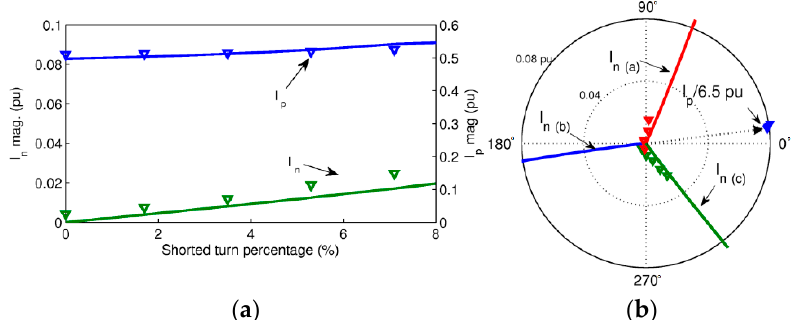
Figure 14. The experimental (symbols) and simulated (solid lines) results at varying shorted turn fault levels of 1.7%, 3.1%, 5.3% and 7.1%: the magnitudes of the positive and the negative sequence currents ( a ) and the negative sequence phasor trajectory for faults in two phases ( b ).